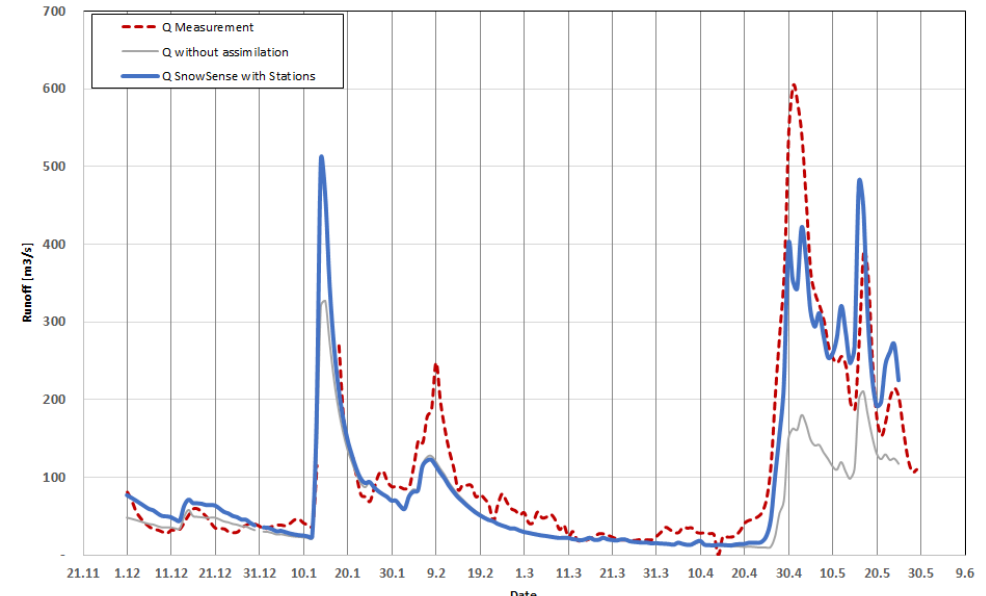
Figure 8. Daily run-off results from PROMET without (grey), with assimilation (blue) of stations and EO against the values (dashed red) measured at Reidville (catchment: 2100 km 2 ) for the winter season